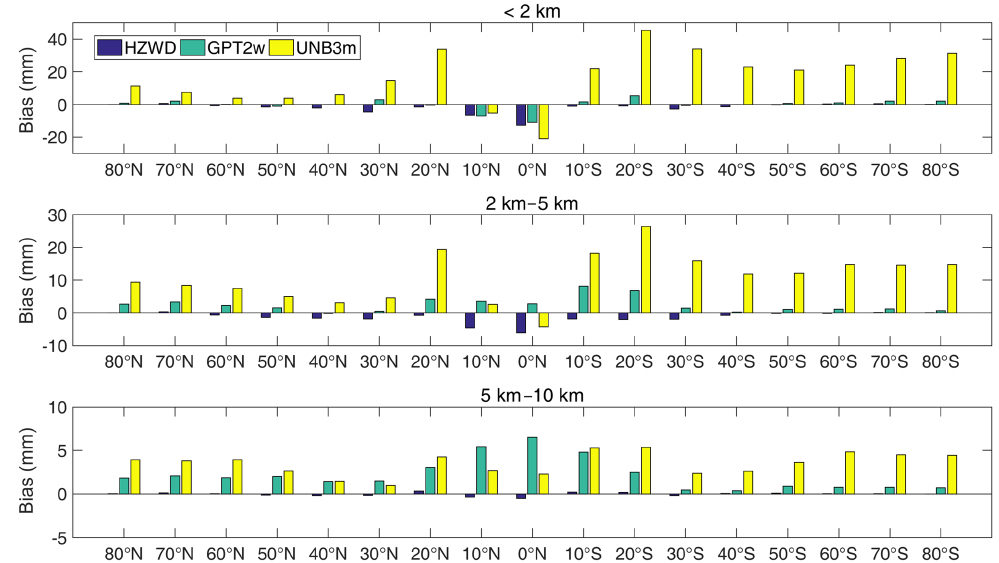
Figure 8. Bias comparisons between the three models (HZWD, GPT2w, and UNB3m) in different latitude bands over the year 2015.